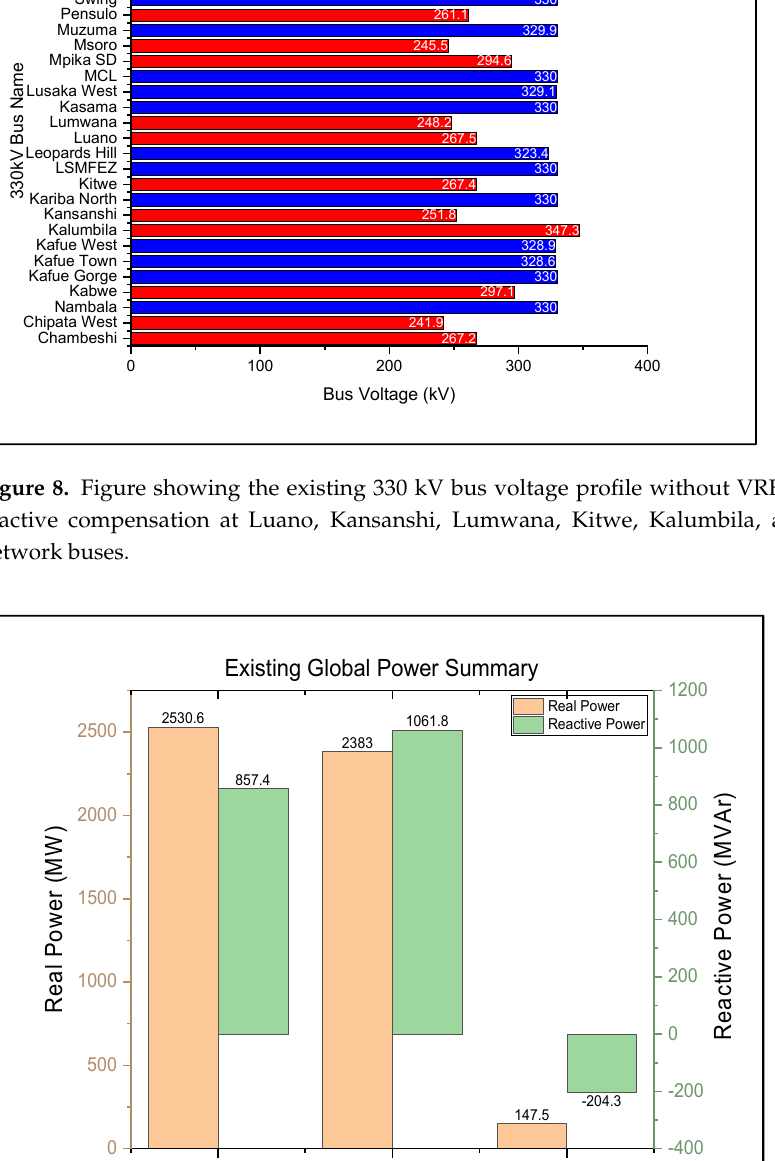
Figure 10. Showing bus voltage after adding network compensation and VRES.